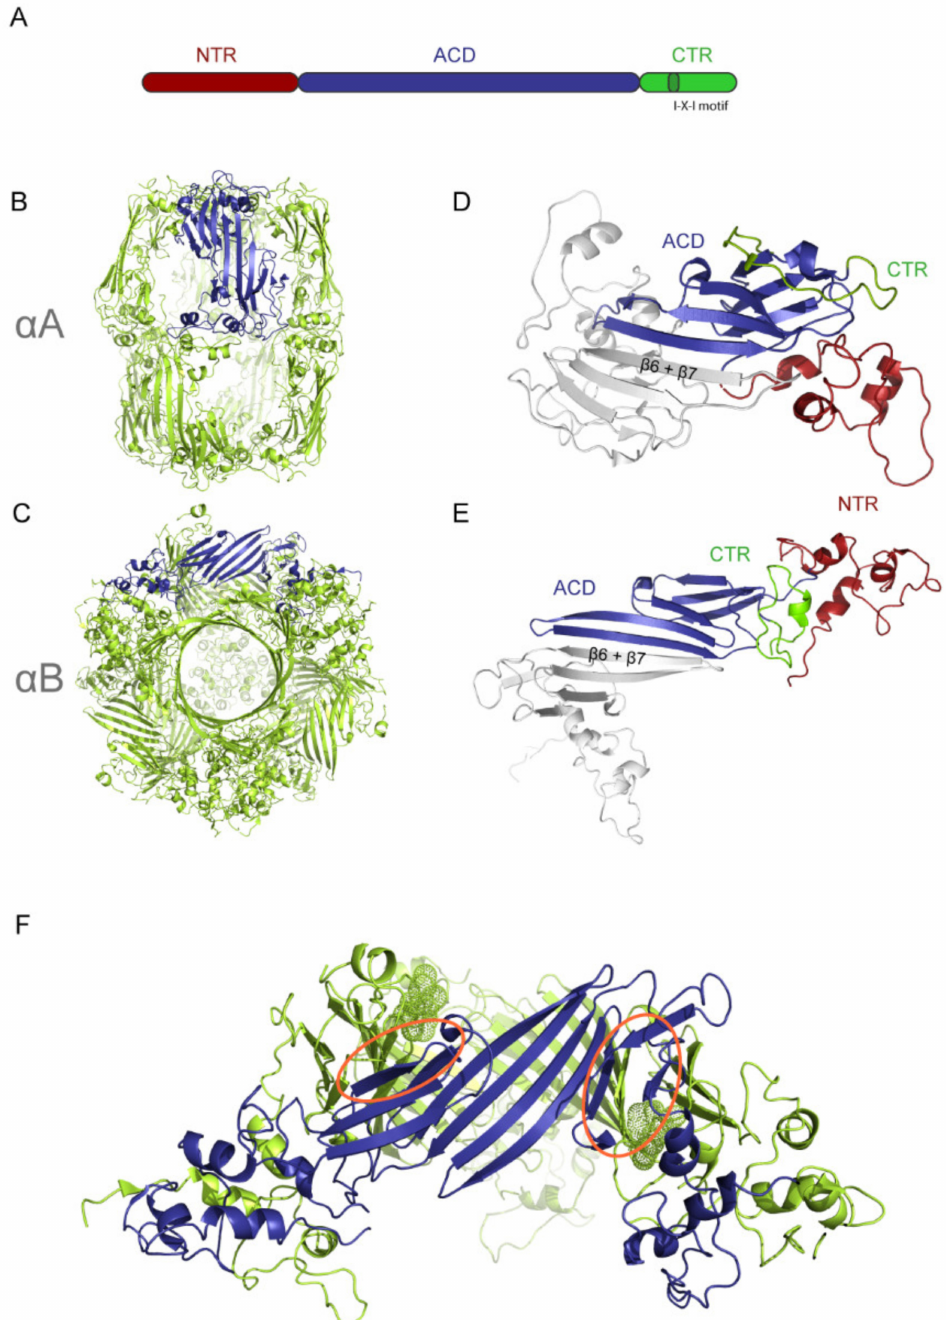
Figure 2. Primary structure of sHsps and structural comparison of α A and α B. Scheme of the common domain organization of a sHsps ( A ). Pseudoatomic models of ( B ) α A (PDB: 6T1R) and ( C ) α B (PDB: 2YGD). Both oligomers are colored in light green except one dimer which is highlighted in blue, respectively. A barrel-like shape is formed by 16 α A molecules with a D4-symmetry. In contrast, α B forms a hollow sphere with a tetrahedral symmetry composed of 24 molecules. For a more detailed comparison of ( D ) α A and ( E ) α B on the dimeric level, a dimer was extracted from each pseudoatomic model. The N-terminal region (NTR) (red), α -crystallin domain (ACD) (blue) and C-terminal region (CTR) (green) were highlighted for one of the dimers. Both NTRs have three helices, albeit they show di ff erent orientations [79,80]. ( F ) Hexameric subunit extracted from the pseudoatomic model of α B (PDB: 2YGD). The interacting IXI motifs are highlighted as dots. The β 4– β 8 groves are marked by orange